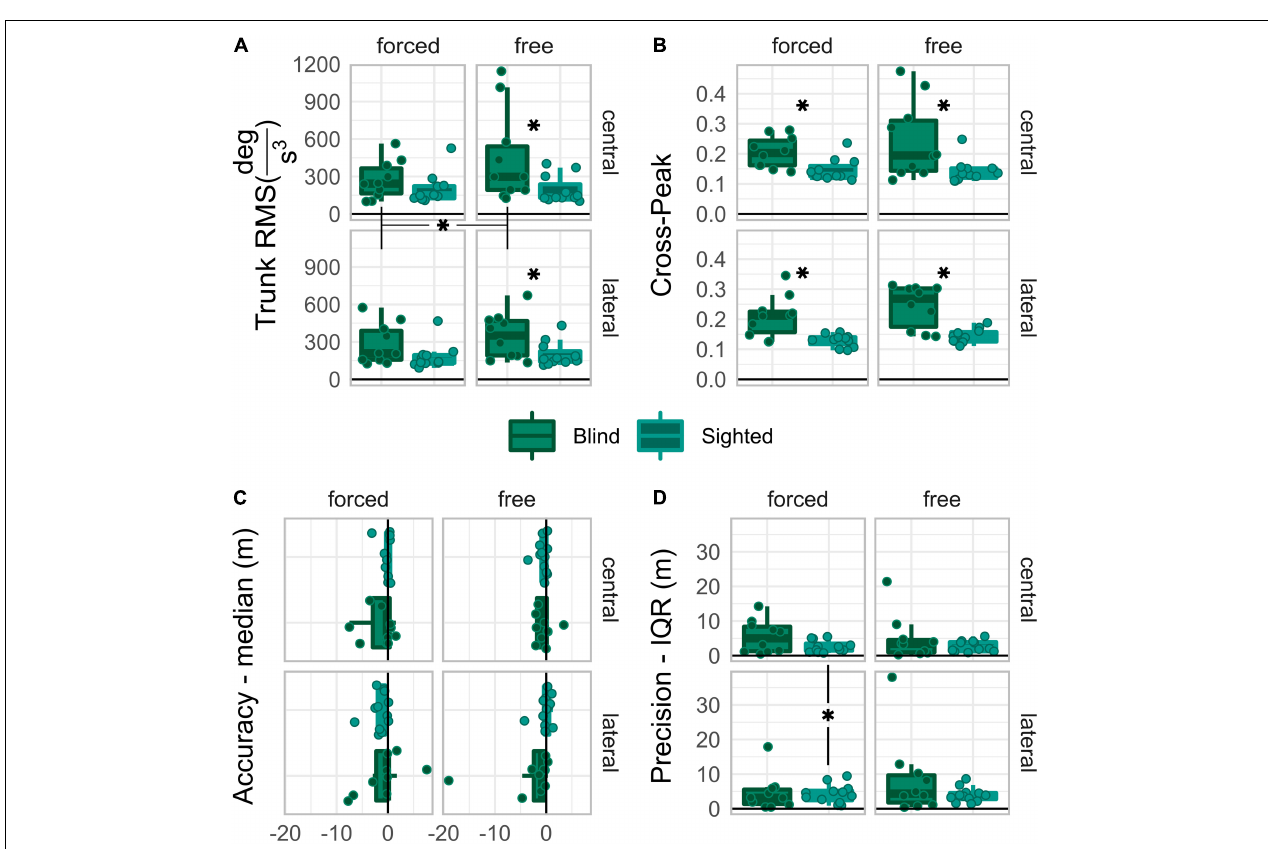
FIGURE 3 | Boxplots of trunk RMS (A) , cross-peak (B) , Accuracy (C) , and Precision (D) , reported for each group and driving condition. Asterisks expose the post-hoc comparisons significances. Those between graphs’ labels expose the within-group main effects. Those in the space between subgraphs expose the 2-way within-group interaction effects. Those between boxplots in the same grid expose significant differences between